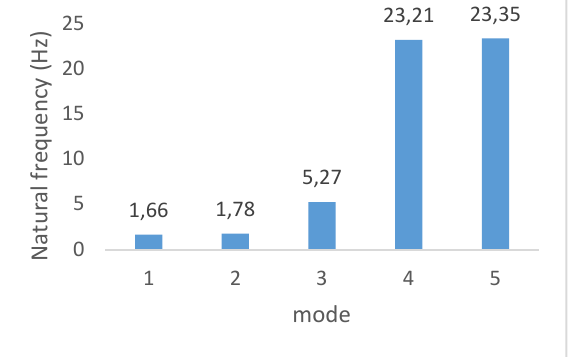
Fig. 8. Rough estimated dependence between Reynolds numbers and vortex shedding frequencies for cylinders of the diameter for the support rods and the glass element.